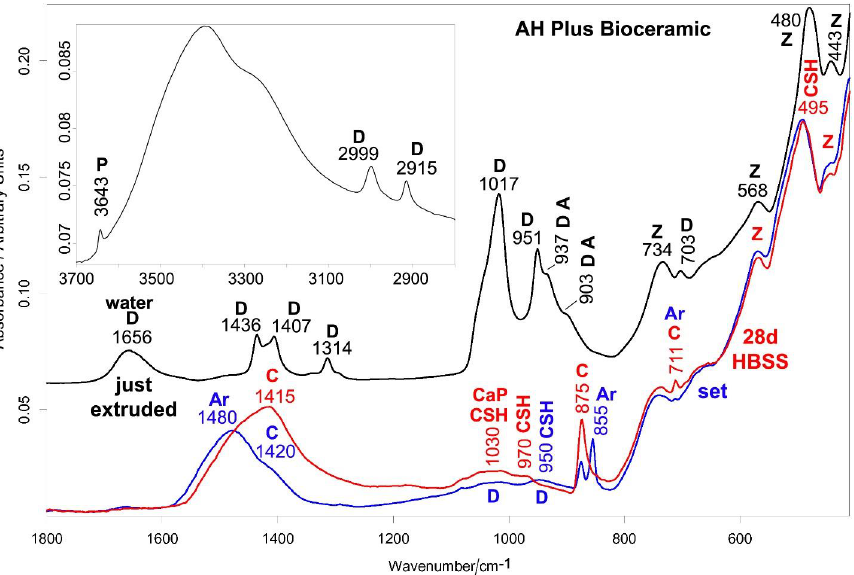
Figure 8. Average IR spectra recorded on just extruded AH Plus Bioceramic (black) as well as on the surface of set disks before (blue) and after aging in HBSS for 28 days (red). The inset shows the 3700 – 2800 cm −1 spectral range of the just extruded sealer. The bands assignable to portlandite (P), dimethyl sulfoxide (D), tricalcium silicate (alite) (A), monoclinic zirconia (Z), CSH phase, calcite (C), aragonite (Ar) and calcium phosphate (CaP) are indicated. Band assignable to water (1656 cm −1 ) was also detected in the just extruded sealer.